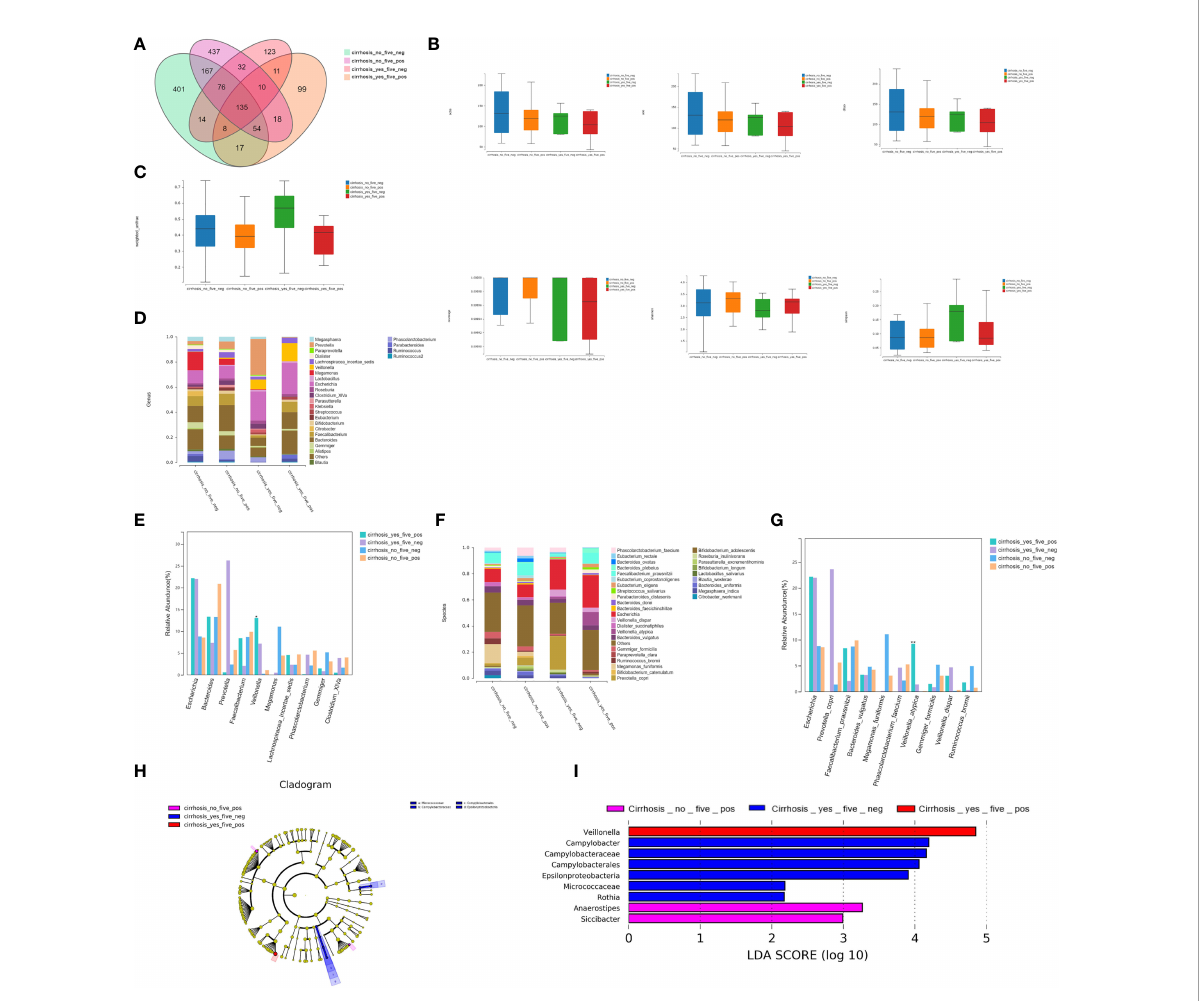
FIGURE 4 Bacterial richness and diversity analysis. (A) We found 135 shared universal OTUs among the four patient subgroups. (B) a -diversity analysis showed no signi fi cant differences in the Simpson ’ s, Shannon ’ s, Sobs, ACE, Chao, or other observed species indexes between the four groups ( P >0.05). (C) The microbial communities differed statistically among the four groups ( P< 0.05). (D) Twenty-seven bacterial genera were detected. (E) The relative abundances of Veillonella were 13.05% for FHRAC-positive patients with LC, 7.18% for FHRAC-negative patients with LC, 0.28% for FHRAC-positive patients without LC, and 1.08% for FHRAC-negative patients without LC (all P< 0.05). (F) Thirty-two bacterial species were detected. (G) The relative abundances of Veillonella atypica were 9.24%for FHRAC-positive patients with LC, 1.40% for FHRAC-negative patients with LC, 0.05% for FHRAC-positive patients without LC, and 0.10% for FHRAC-negative patients without LC (all P< 0.05). (H) LEfSe analysis showed that samples from the FHRAC-negative patients with LC contained mainly Campylobacteraceae at the class level, Campylobacterales at the order level, and Micrococcaceae and Epsilonproteobacteria at the family level. (I) Anaerostipes , Campylobacter , Campylobacteraceae , Epsilonproteobacteria , Veillonella , Rothia , Siccibacter , Micrococcaceae , and Campylobacterales were differentially expressed among the taxonomic